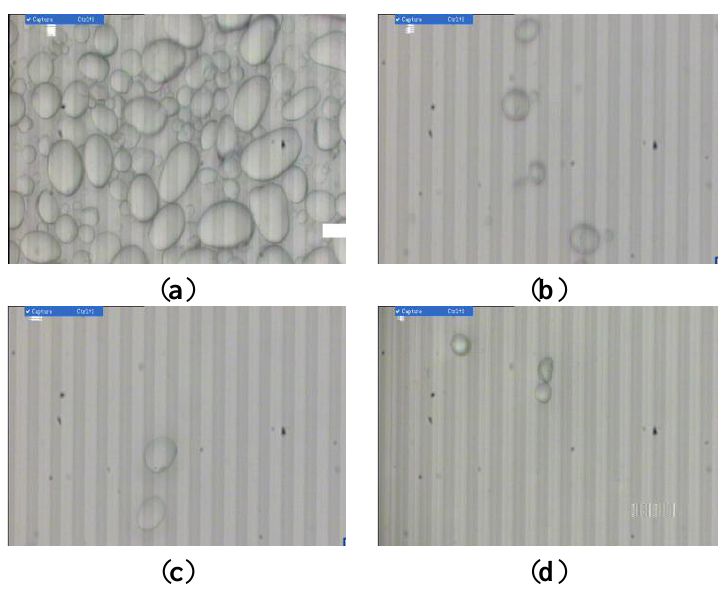
Figure 16. The separation results of the wheat particles. ( a ) Non-separated wheat particles; ( b ) the first separation sample; ( c ) the second separation sample; ( d ) the third separation sample.